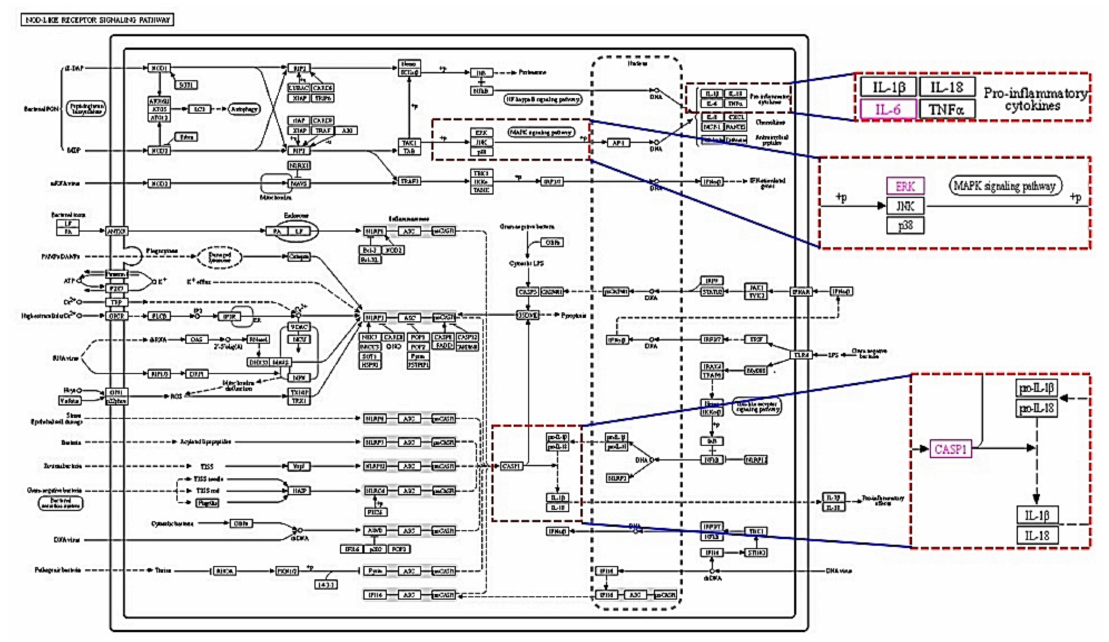
Figure 7. NOD-like receptor signaling pathway. Red dotted line indicated IL6; MAPK1 (known as ERK); and CASP1 location. Pink colors represent target proteins of ICLs on